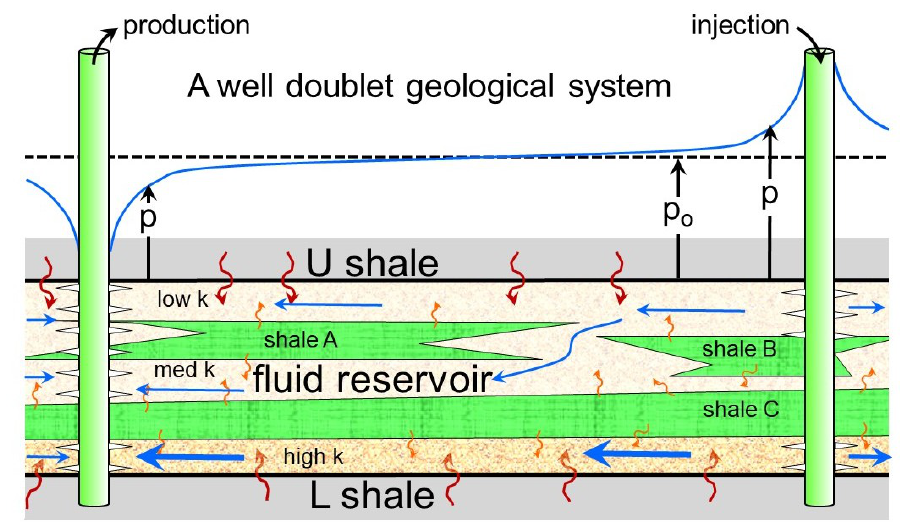
Figure 8. Geological disposition factors in doublet efficacy.